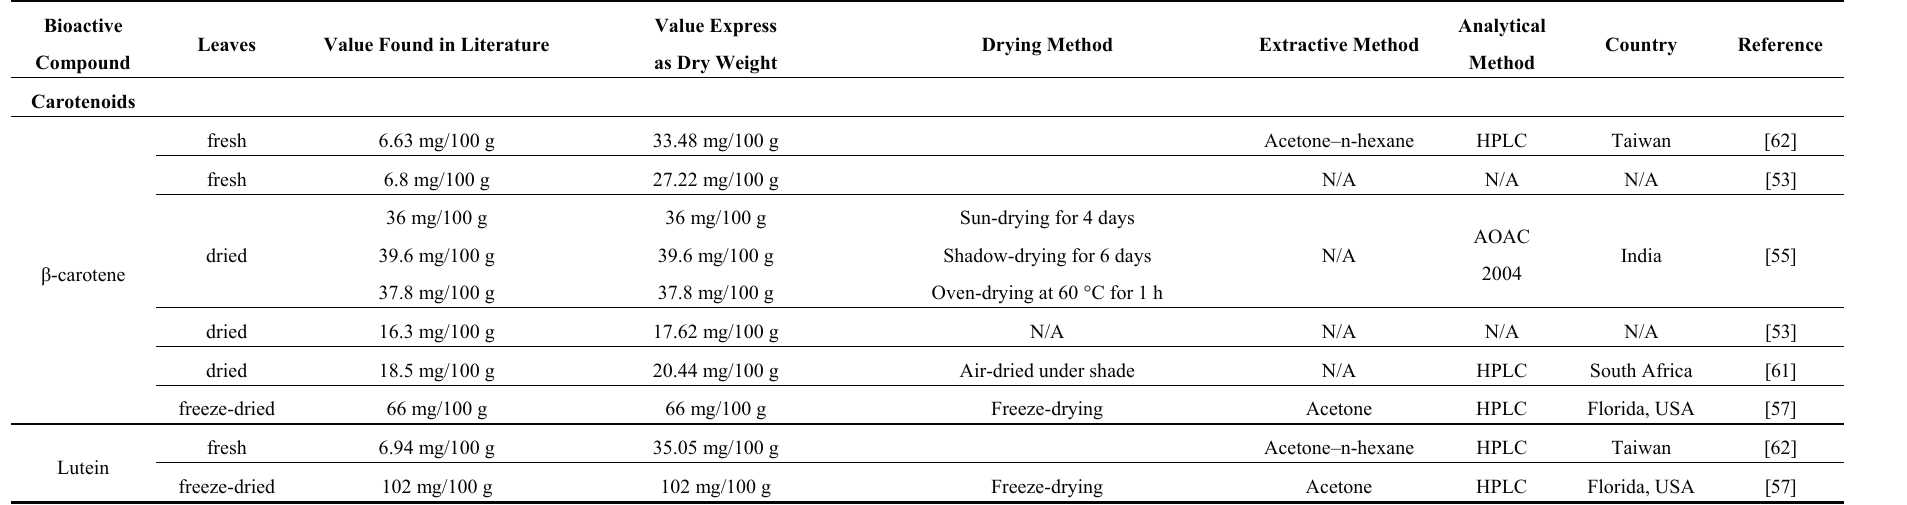
Table 2. Carotenoids content in Moringa oleifera